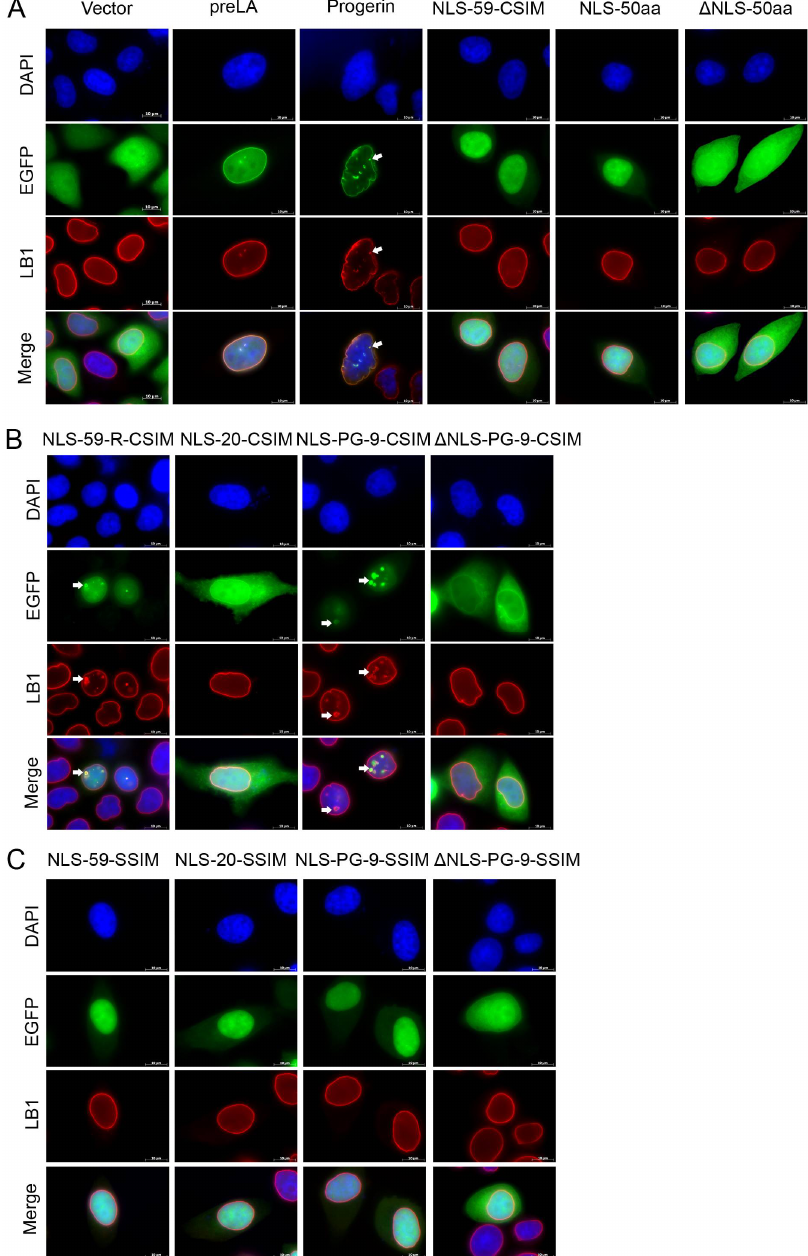
Figure 2. Determination of the cellular localization of EGFP plasmids in transiently transfected HeLa cells. Immunocytochemistry was performed on HeLa cells transfected with EGFP fusion proteins. Cells were stained with an anti-lamin B1 antibody. Chromatin was stained with DAPI. Representative images of lamin B1 staining in the indicated cells. ( A ) NLS directs the protein to the cell nucleus. ( B ) The farnesylated CaaX motif, along with the NLS, targets the EGFP–NLS-59-R-CSIM and EGFP–NLS-PG-9-CSIM proteins to the nuclear envelope (NE) and EGFP–NLS-20-CSIM protein to the NE and cytoplasm and membrane. ( C ) Proteins carrying the C661S mutation within the CaaX motif exhibit an intra-nucleoplasm diffusion pattern. Scale bar, 10 μm.